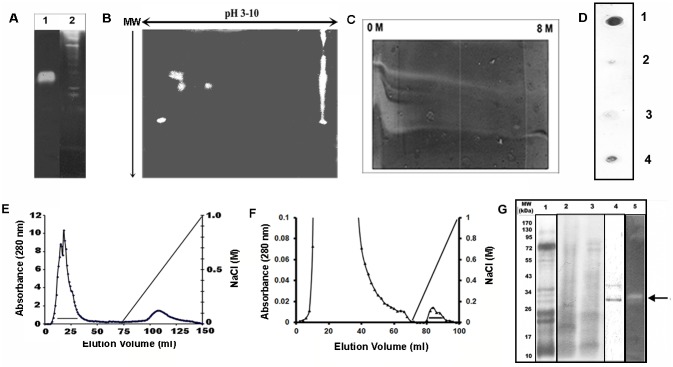
Detection and purification of fibrinolytic component from the aqueous extract of the root of Aristolochia indica.
(A) fibrin zymography. Lane 1, plant extract (35.5 μg); lane 2, plasmin (5 μg). The lanes were selected from two different zymograms run under identical conditions. (B) 2-D fibrin zymography of the root extract (350 μg) showing the presence of multiple components; 5 spots in the acidic zone and one trailing lane in the alkaline zone. (C) Transverse 0–8 M urea gradient fibrin zymography showing presence of multiple enzymes which are stable up to variable denaturant concentrations. (D) dot blot analysis of 1, plasmin; 2, BSA and 3, Russell’s viper venom L-amino acid oxidase; 4, A. indica root extract developed against rabbit polyclonal human plasminogen antibody. (E) DEAE cellulose chromatography of the crude extract where a linear gradient of 0–1 M NaCl was applied. The bar represents the active fractions that were pooled; (F) substrate affinity chromatogram of the pooled fractions from DEAE-chromatography. The bound fractions were eluted by the application of 0-1M NaCl and the bar represents the active fractions. (G) SDS-PAGE of the plant extract (lane 1), unabsorbed fraction from DEAE cellulose column (lane 2), unabsorbed fraction from substrate affinity column (lane 3), absorbed fraction from substrate affinity column (lane 4) and fibrin zymography of the same sample (lane 5). The arrow indicates position of fibrinolysis. The position of the marker proteins is indicated at the left.